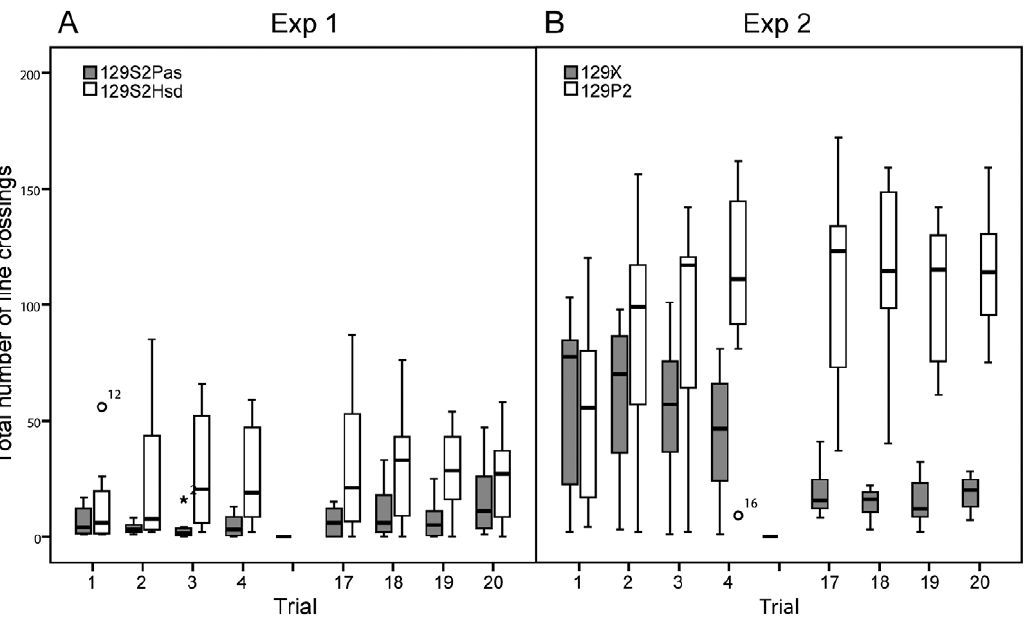
Figure 3. Total number of line crosses (median ± IQR) on the first day and last day of testing (trials 1–4 and 17–20). (3A) Experiment 1: 129S2Pas and129S2 mice, (3B) experiment 2: 129X1 and 129P2 mice.